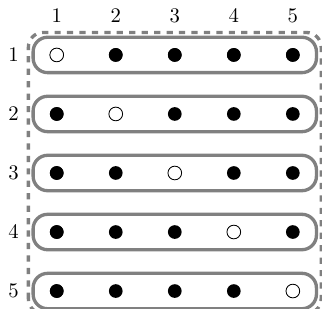
Figure 1 . The lattice for a system of n = 6 doublets. The black nodes correspond to valid U -spin pairs, while the white nodes on the diagonal are forbidden and do not describe any U -spin pair. Harvesting of the sum rules is performed as follows. The black nodes give the leading order, that is, b = 0 , a -type sum rules. Sums of nodes grouped by solid lines give the b = 1 , s -type sum rules. The sum of nodes within the dashed line gives the a -type sum rule that is valid up to b = 2 . Note that we do not explicitly show the identical b = 1 sum rules that are obtained by vertical instead of horizontal solid